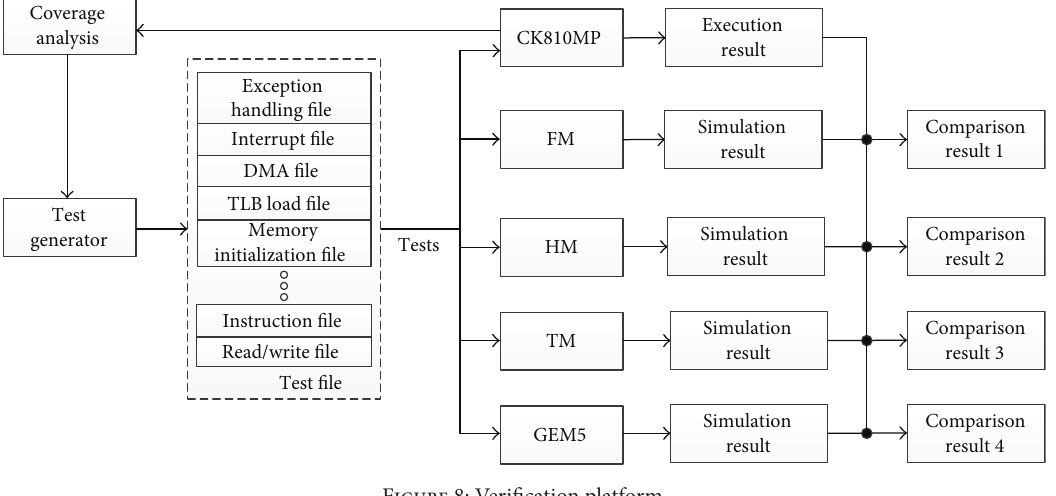
Figure 8: Verification platform.